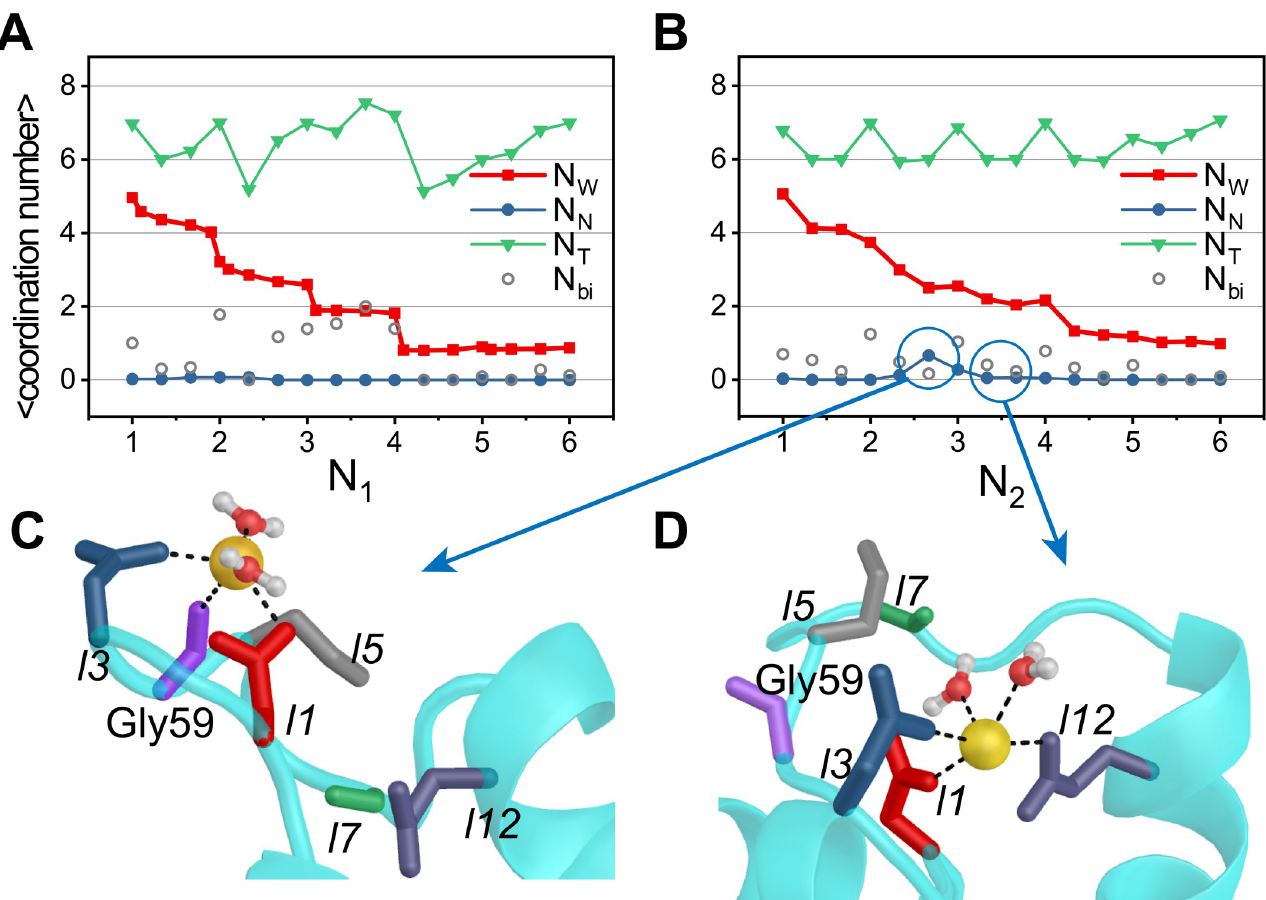
Fig 3. Number of coordinated water molecules ( N W ), non-native ligands ( N N ) as well as the total coordination number ( N T ) as functions of N 1 and N 2 for EF 1 (A) and EF 2 (B). Only one carboxyl oxygen atom of aspartate is coordinated to the Ca 2+ in the native coordination structure. Nevertheless, the second carboxyl oxygen atom may also bind to the Ca 2+ in the intermediate state of the coordination. The average number of such non-native bidentate ligands is also shown in panels A and B (N , gray). (C) The non-native ligand Gly59 (purple) coordinated to Ca 2+ when N 2 = 2 * 3. (D) When N 2 = 3, Glu67 ( l 12, purple) is bi coordinated to Ca 2+ , and the bond formed by Gly59 and Ca 2+ is broken.